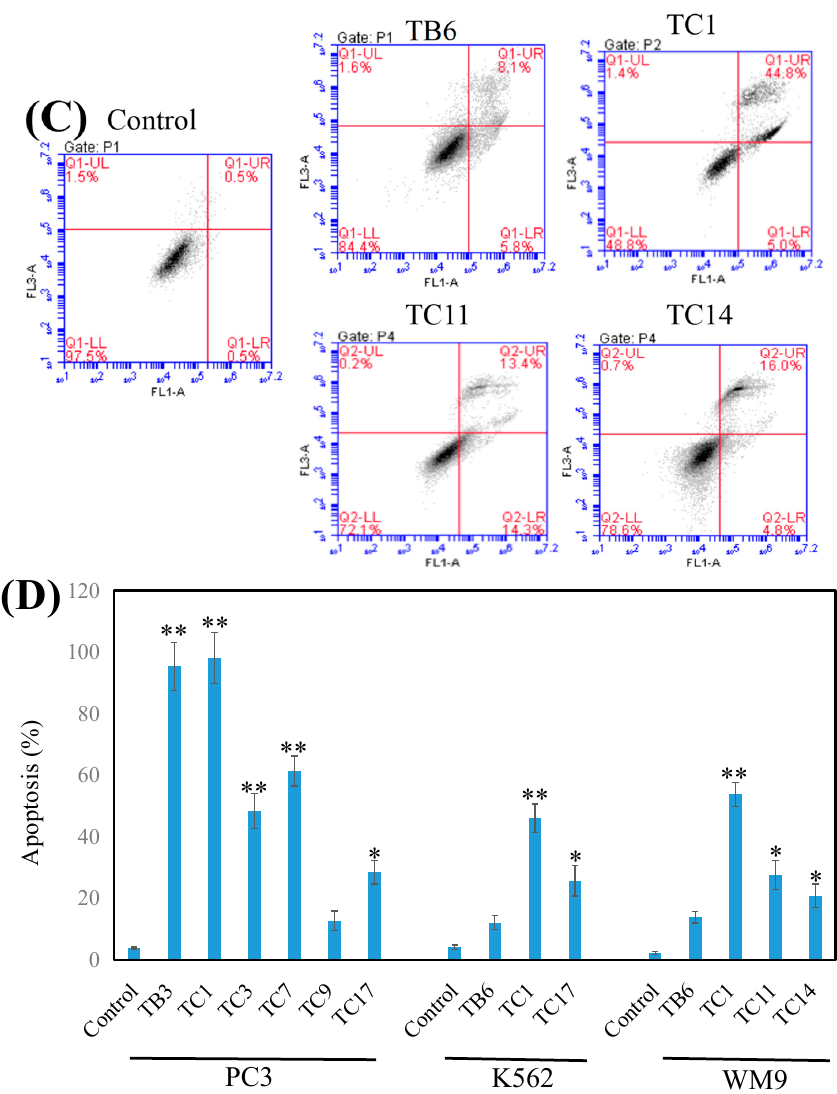
Figure 4. Effects of the active compounds on PC3 ( A ), K562 ( B ) , and WM9 ( C ) cell growth and apoptosis. Cell apoptosis induced by the compounds and tested by flow cytometry and the date was analyzed with Origin Pro 9.0 ( D ) and presented as means ± SEM from at least three independent experiments. * p < 0.05, ** p < 0.01 ( n = 3) as compared with the control.